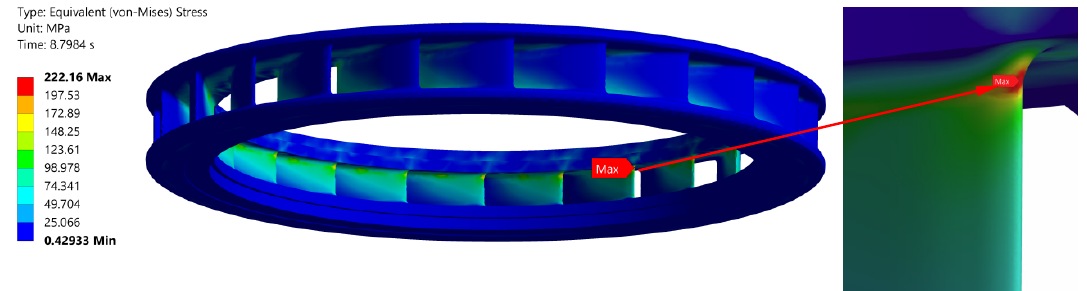
Figure 20. Von Mises stress distribution on the stay ring.